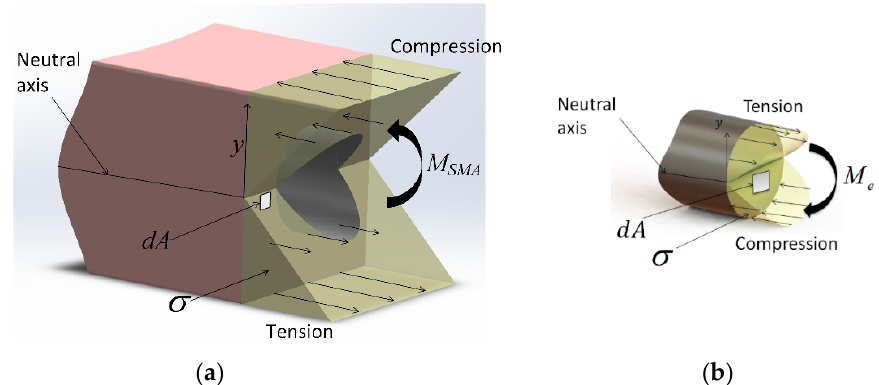
Figure 5. Cross-sectional stress distributions across ( a ) the elastic sleeve and ( b ) SMA tendon.